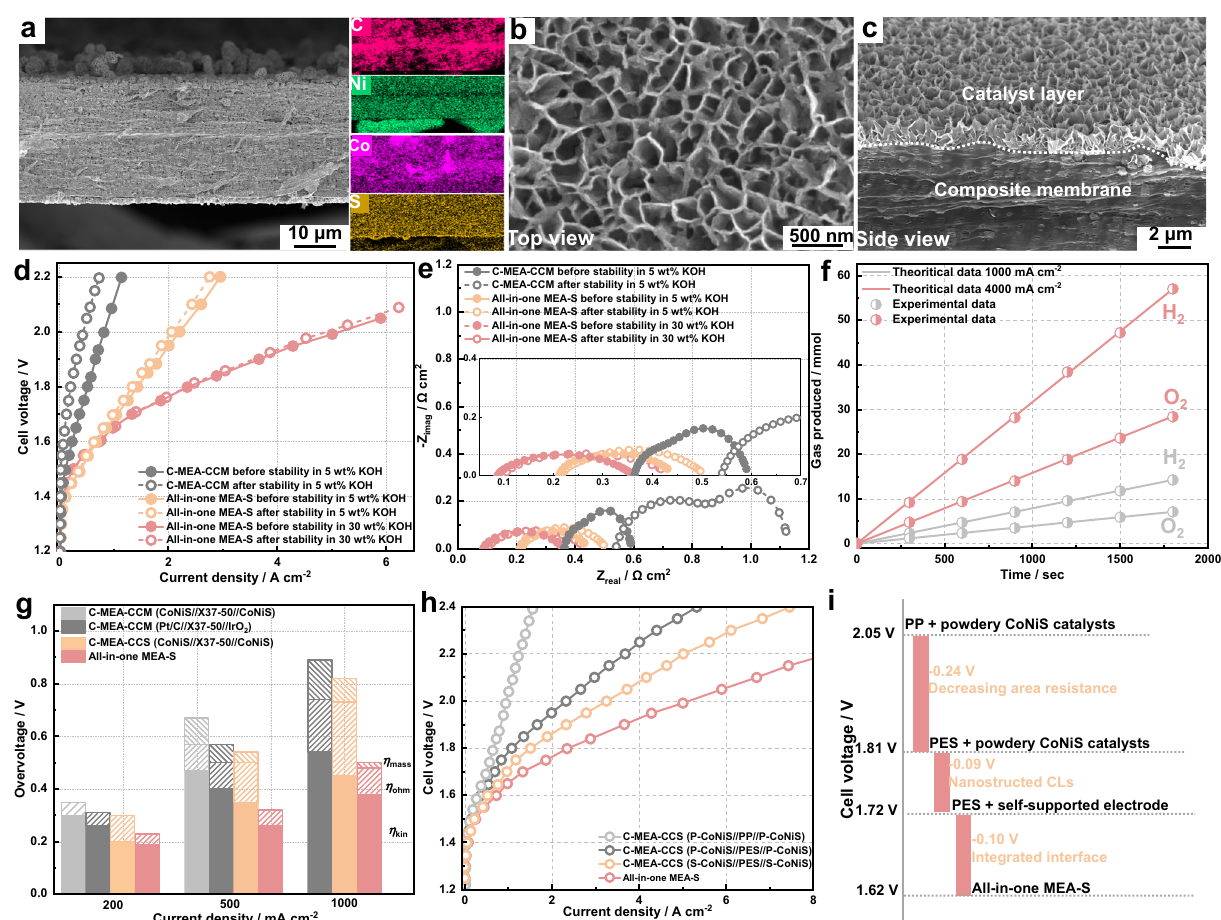
Fig.5|Stabilityandincreasedperformanceoftheall-in-oneMEAs. Morphology structure analysis after electrolysis for 600h: a Cross-sectional SEM image of the all-in-one MEA-S and corresponding EDS mapping. b Surface and c cross-sectional SEMimagesoftheCL. d PolarisationcurvesoftheC-MEA-CCMandall-in-oneMEA-S before and after stability tests. e Nyquist impedance plots of the C-MEA-CCM and all-in-one MEA-S before and after stability tests. f Volumes of H 2 and O 2 generated by the advanced alkaline water electrolysis using the all-in-one MEA-S at different current densities of 1000 and 4000mAcm − 2 under atmospheric pressure. g Bar